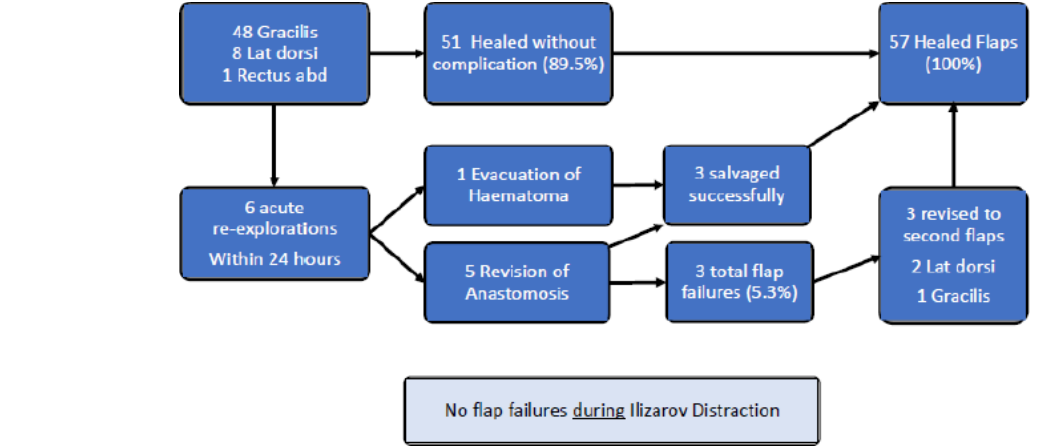
Figure 3. Outcome of the Free Muscle Flaps in all 57 patients.